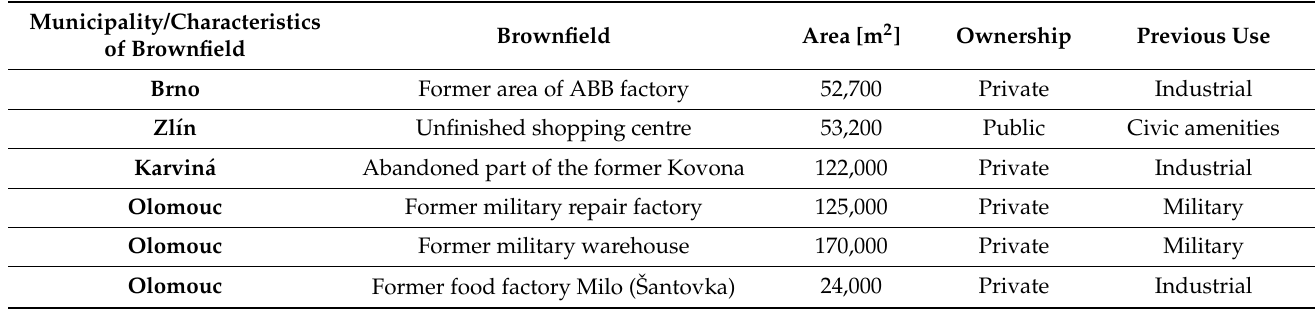
Table 2. Basic characteristics of the brownfields whose neighbourhoods were selected for our research.